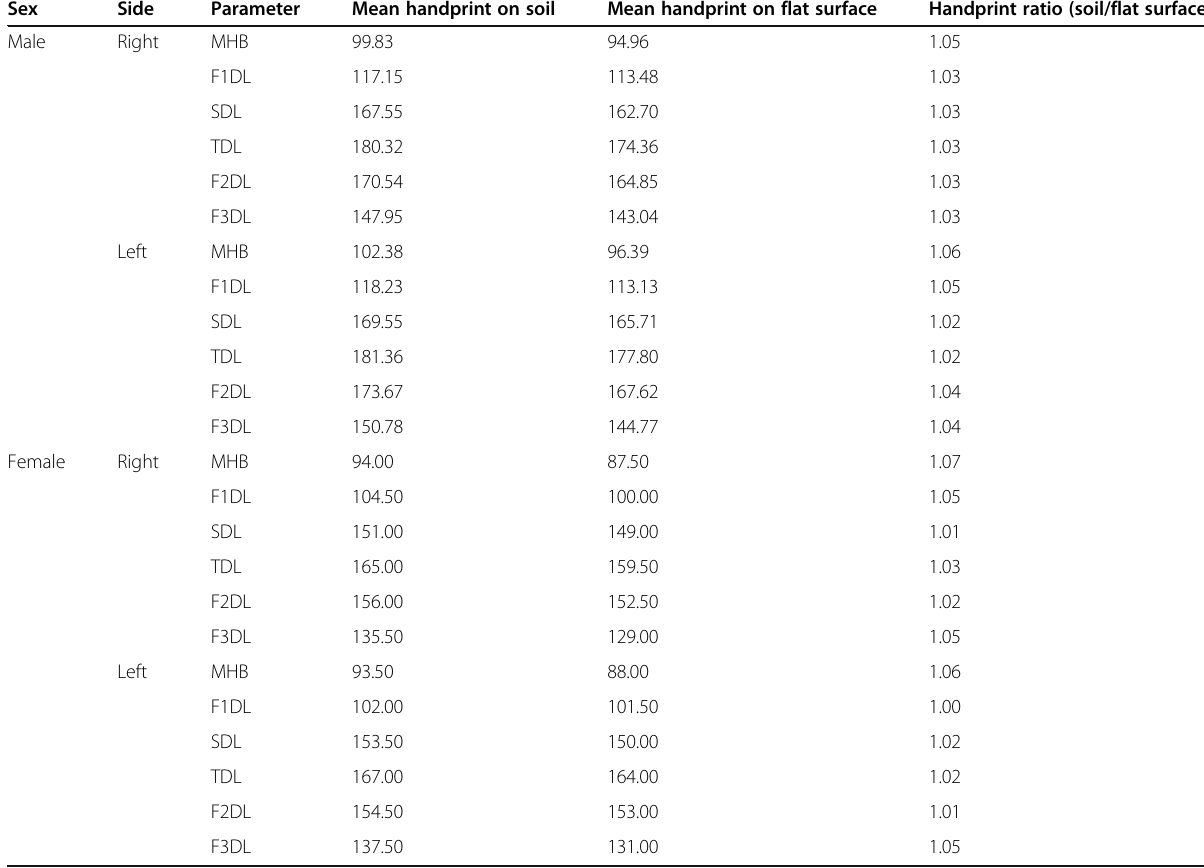
Table 8 Difference of handprint measurement on soil and flat surface Sex Side Parameter Mean handprint on soil Mean handprint on flat surface Handprint ratio (soil/flat